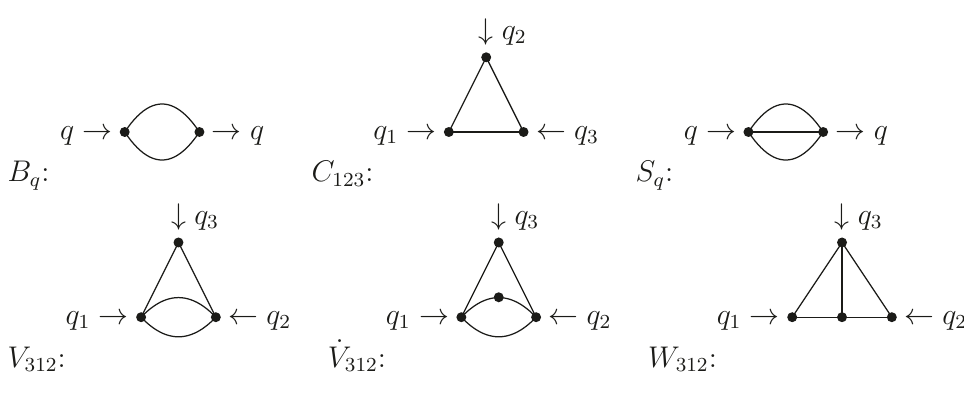
Figure 3 . Master integrals appearing in the two-loop calculation. The dot on the propagator in ˙ V 312 corresponds to a doubling of that